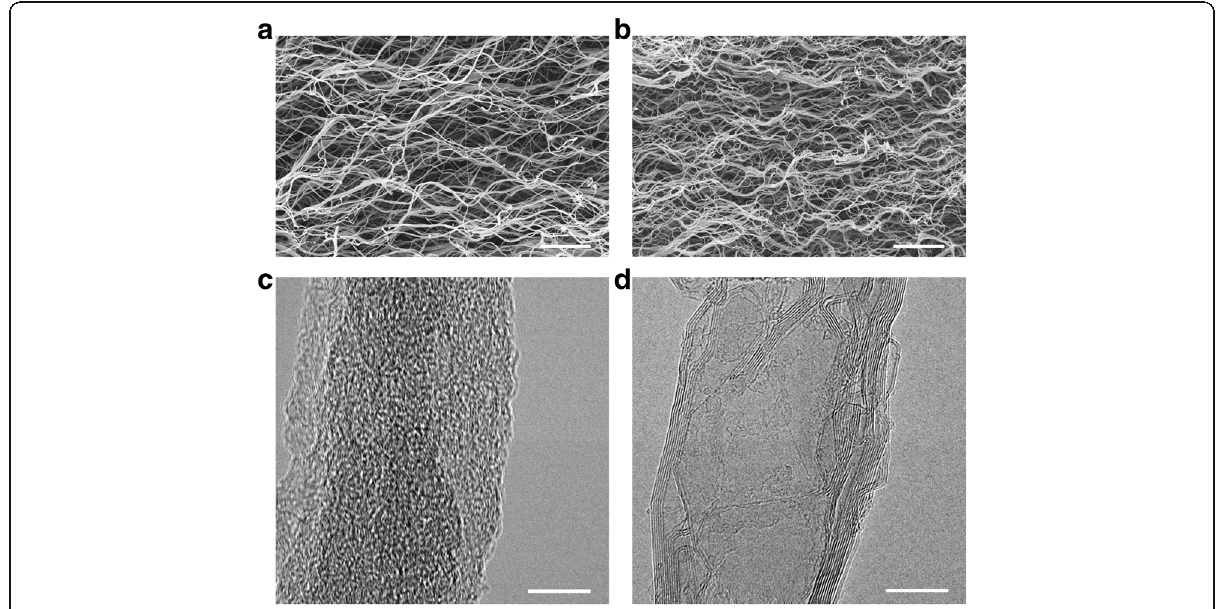
Fig. 1 FE-SEM images of a HM-CNWs and b HM-GNWs and FE-TEM images of c HM-CNWs and d HM-GNWs. Scale bars in the FE-SEM and FE-TEM images are 2 μ m and 10 nm,